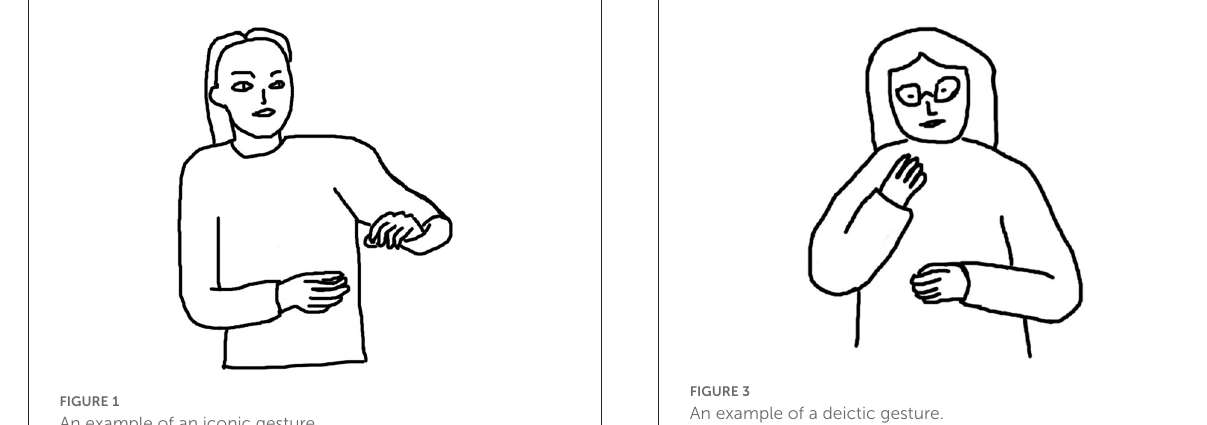
FIGURE3 An example of a deictic gesture.